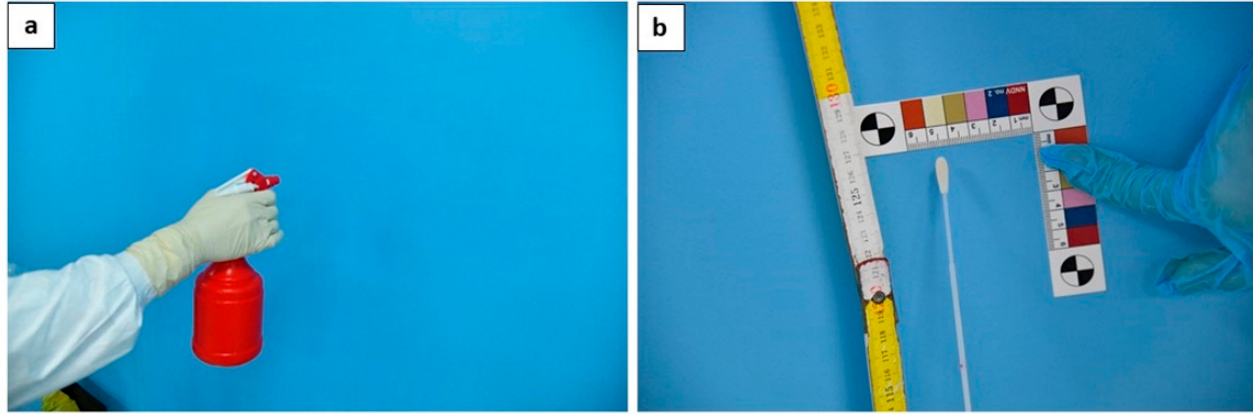
Figure 4. The disinfection procedure is performed through nebulization ( a ); at the end of the procedures, one swab for each wall was taken ( b ).